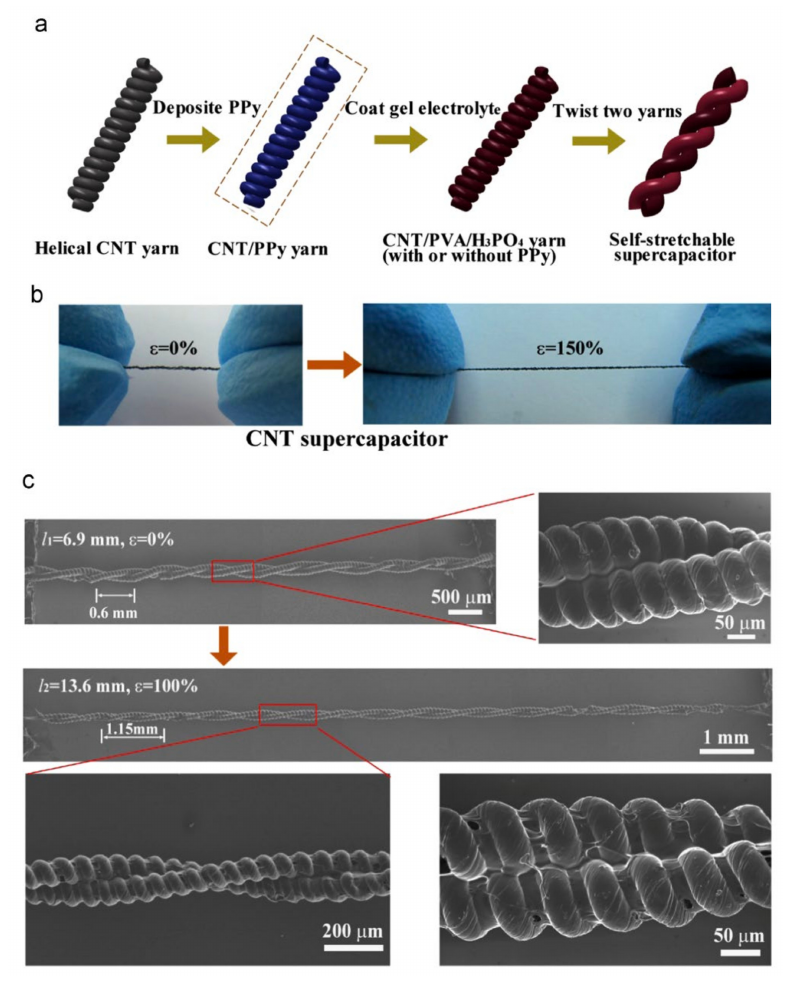
Figure 17. Fabrication of self-stretchable fiber-shaped supercapacitors. ( a ) Schematic of the freestand- ing helical CNT yarn SC fabrication process. Two of such yarns were twisted into a double-helix supercapacitor. ( b ) Photograph of manually stretched (1.5 times the original length) double-helix CNT yarn supercapacitor. ( c ) SEM images of a 6.9-mm-long supercapacitor in its original state (l 1 = 6.9 mm, ε = 0) and after stretching to l 2 = 13.6 mm, ε = 100%, showing uniform deformation of helical loops and a continuous electrolyte coating on the surfaces of the yarns. Reprinted with permission from [92].